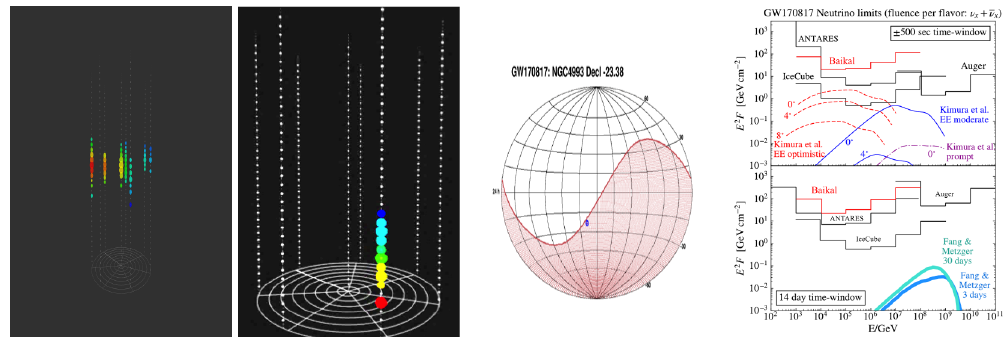
Figure 3. Left1: Reconstructed cascade event with energy 154.9 TeV. Left2: Reconstructed vertical event with 10 hit OMs. Centre: Horizon of the Baikal-GVD in alert time of the GW170817A (blue point). Right: The Baikal-GVD upper limits on neutrino fluences from direction of the GW170817A event (see text).